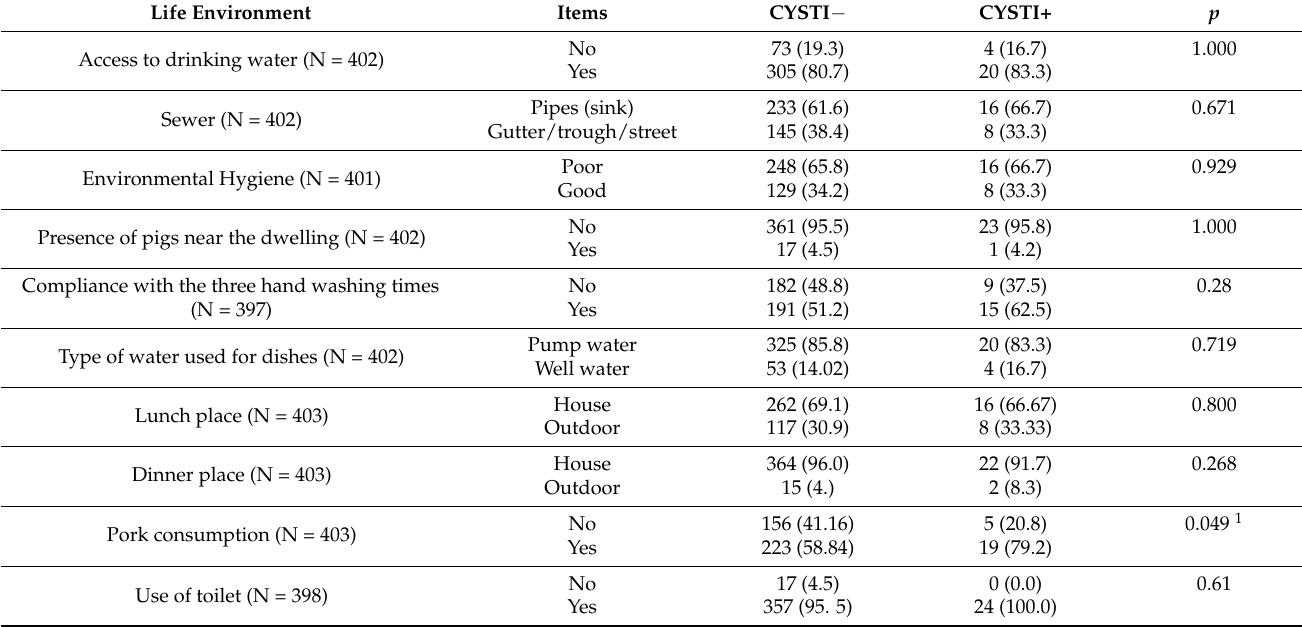
Table 3. Hygienic habits and living environments of epileptic patients included in the study by cysticercosis serologic status. Life